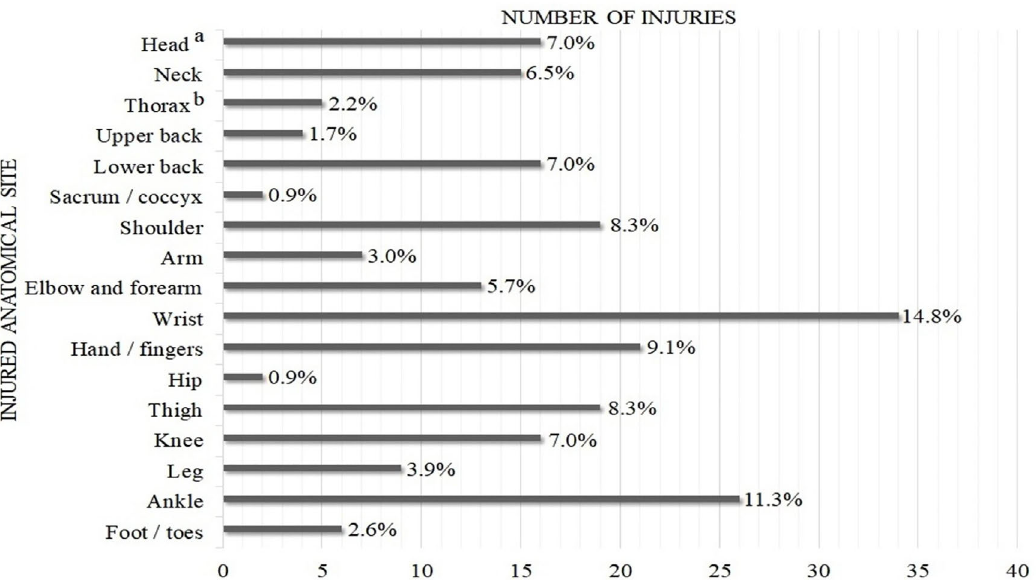
Figure 1 - Percentage and number of injuries per anatomical site. a Head: includes eyes, ears, mouth, and nose. b Thorax: includes rib and sternum, abdo- men. In total, 230 injuries were